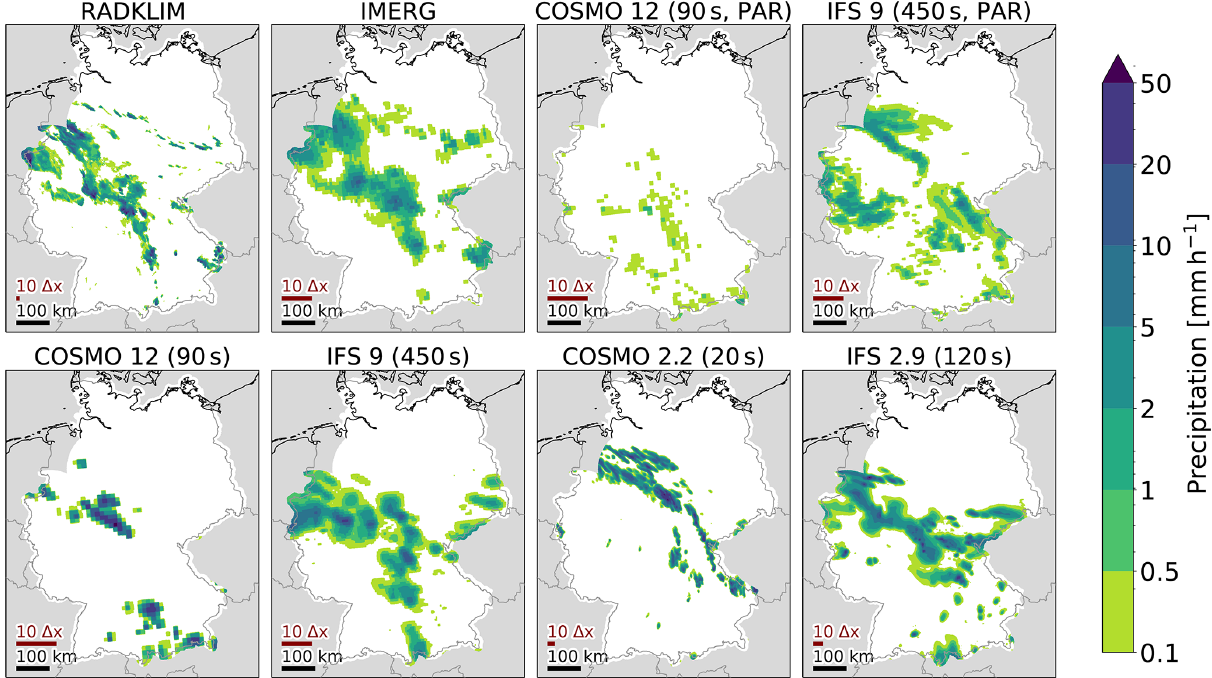
Figure 2. Accumulated hourly precipitation interpolated to the RADKLIM domain over Germany. While IMERG and the results from the model runs show precipitation from 17:00 to 18:00UTC on 29 May 2018, the corresponding RADKLIM interval is 16:50 to 17:50UTC (see Sect.